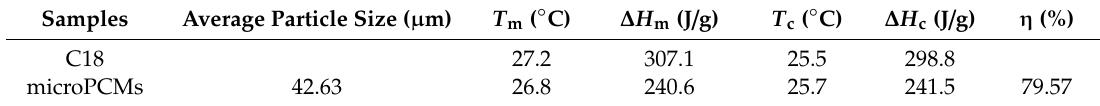
Table 1. The Phase Change Properties of C18 and MicroPCMs.